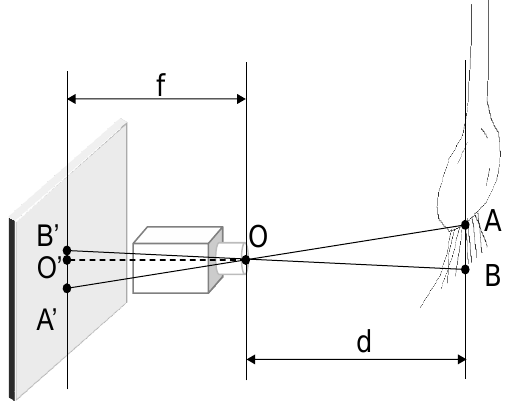
Figure 3. Schematic diagram of garlic root length measurement.